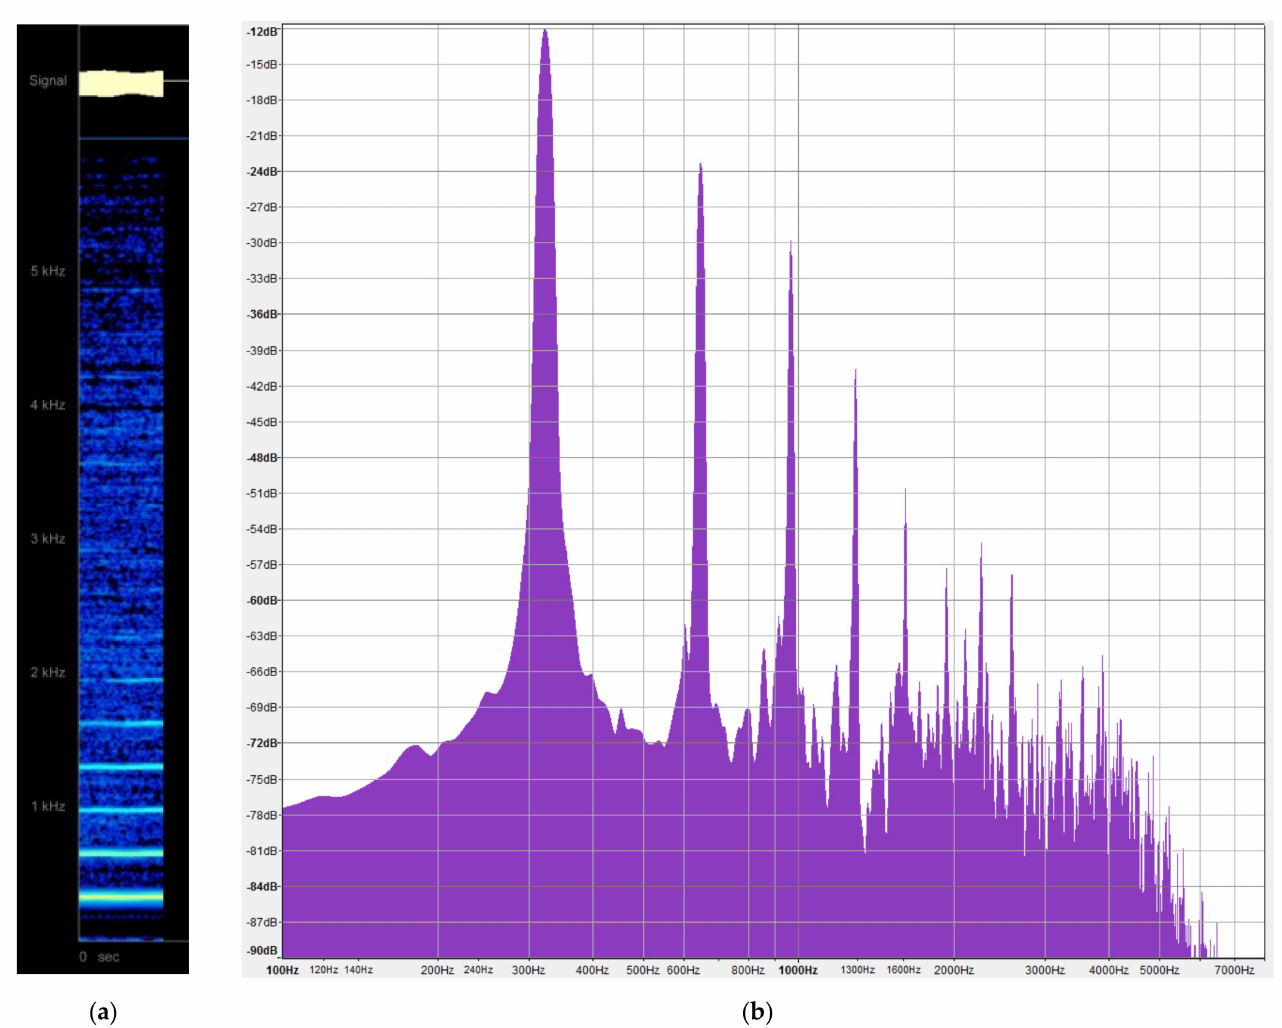
Figure 6. Spectral components of shell horn made from Triplofusus princeps . Experimental model, low blowing pressure: ( a ) spectrogram; ( b ) spectrum (Sample